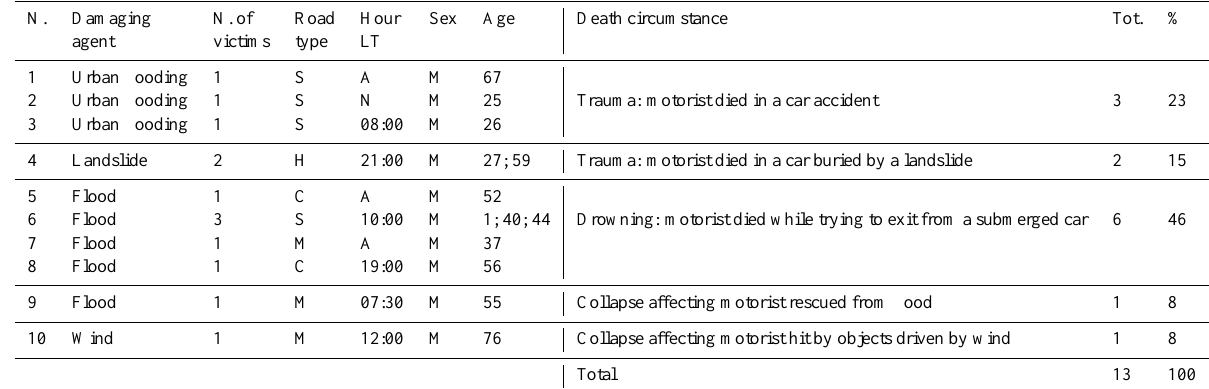
Table 2. Cases of damage resulting in victims. For each record, the following data are reported: damaging agent, number of victims, road type (H = Highway; S = State road; C=County road; and M = Municipal road), hour at which the damage occurred (A = afternoon), the sex of victim (M = male; F = female), age of victim, and death circumstance.